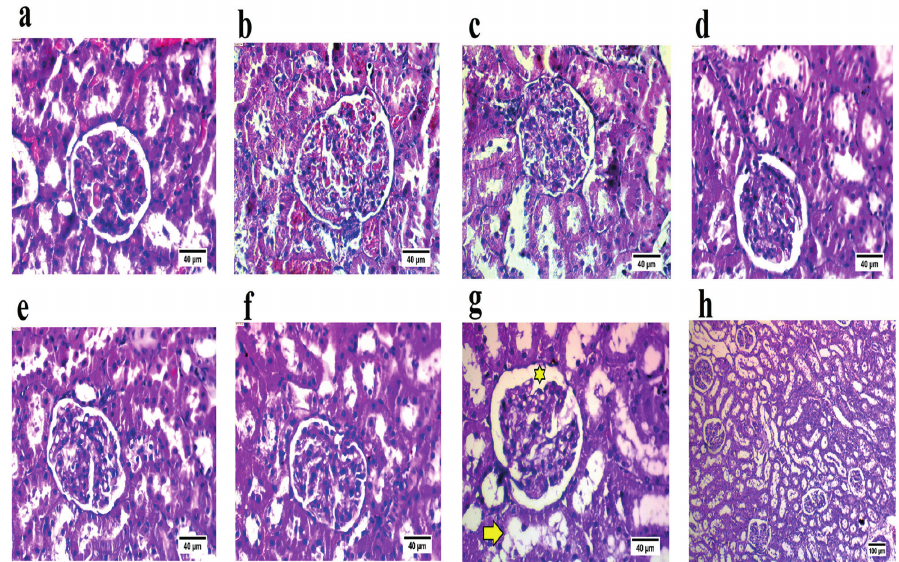
Figure 1 - Histopathological assessment of the kidney sections of rats in the control ( a ), Olive 10% ( b ), Olive 20% ( c ), Cottonseed 10% ( d ), Cottonseed 20% ( e ), Sesame oil 10% ( f ) and Sesame oil 20% ( g , h ). The sections were stained with hematoxylin and eosin dyes. The star represents urinary space dilatation and arrow shows a proximal tubule with lysosome accumulation.